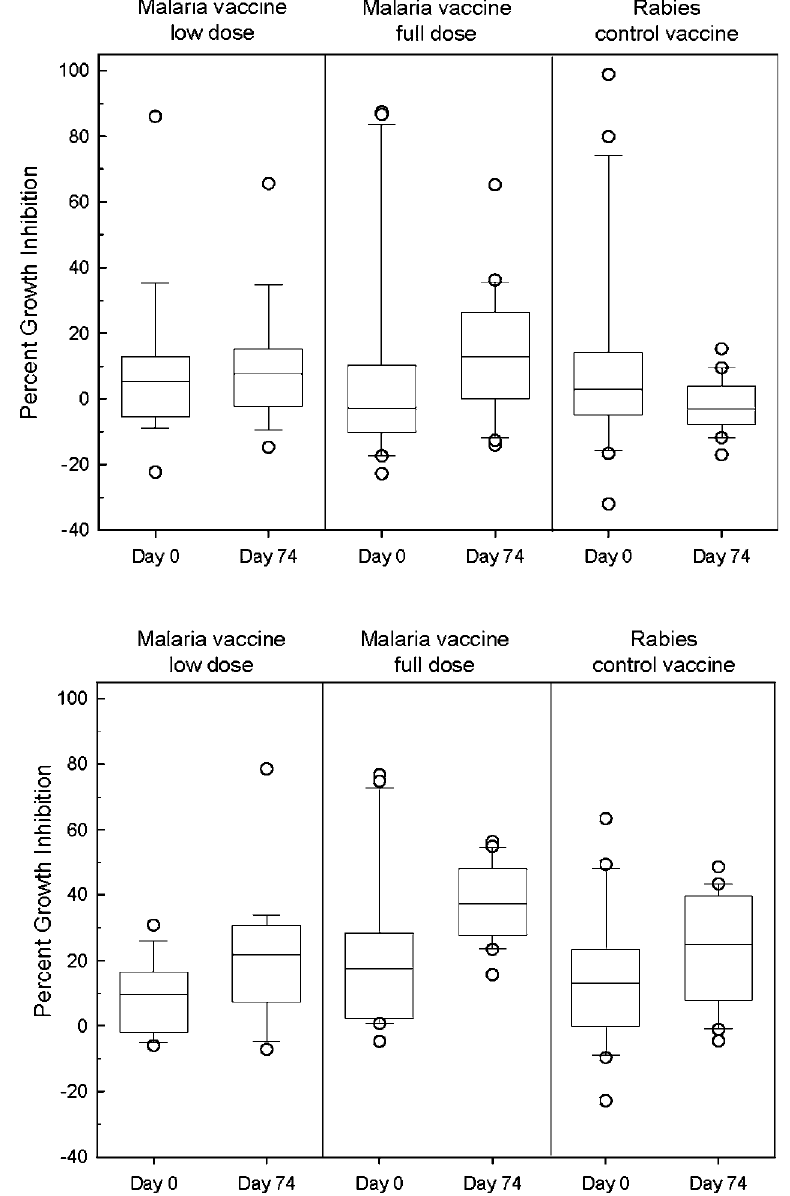
Figure 3. Growth inhibition assays. Mean percent growth inhibition of pre- and post-immunization sera against the 3D7 (A) and FVO (B) clones of Plasmodium falciparum grown in vitro. Error bars represent 95 percent confidence